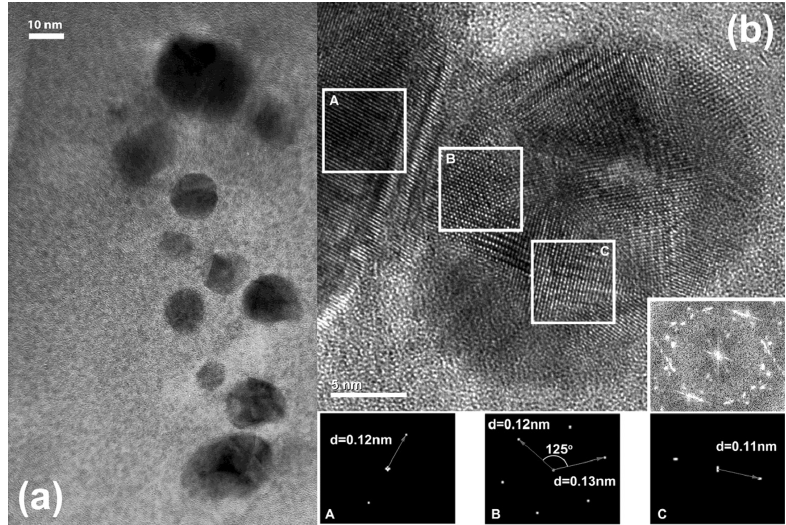
Figure 8. A typical (a) TEM and (b) HR-TEM view of the bigger aggregates of nanoparticles that were found in our dried samples. Inset in (b) represents the Fourier transform of (b) and regions A, B and C were chosen to analyze their own Fourier transforms which are correspondingly depicted below as well as the measured d-spacings and angles. In this case, micrographs correspond to a Sol-8020